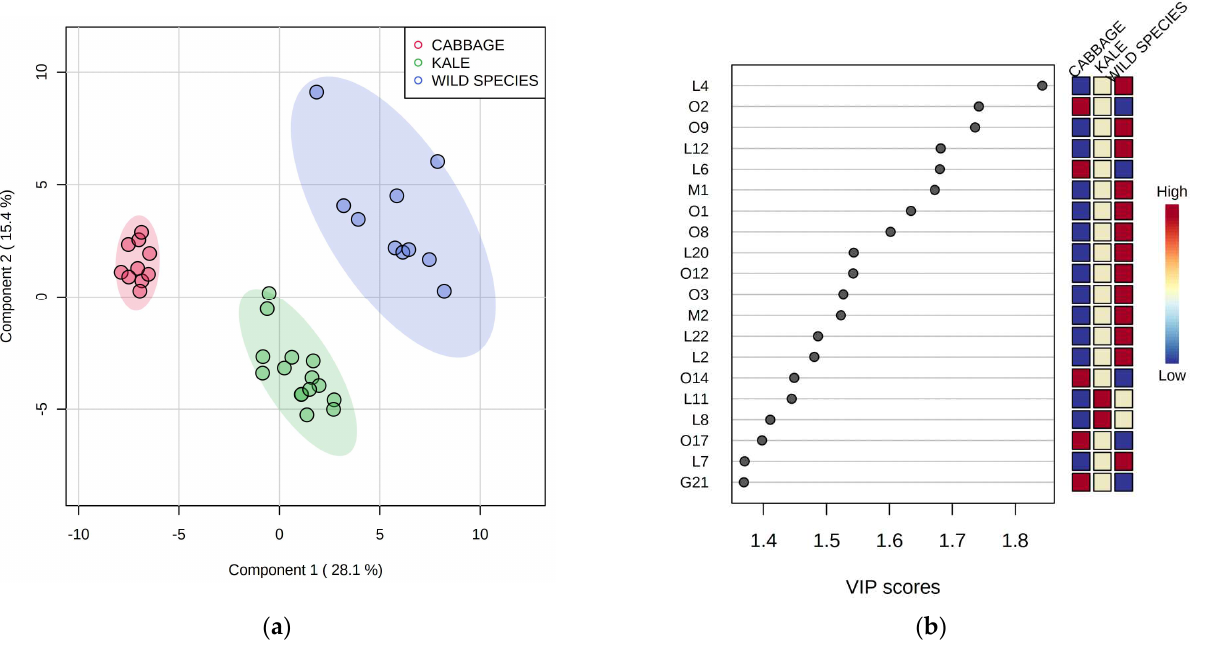
Figure 6. ( a ) Differentiation of Brassicaceae species in two-dimensional space by partial least squares−discriminant analysis (PLS−DA); ( b ) variable importance in projection (VIP) scores of volatile compounds (variables) from all biochemical pathways most useful for the differentiation. Codes indicating compounds correspond to those reported in Table 1.